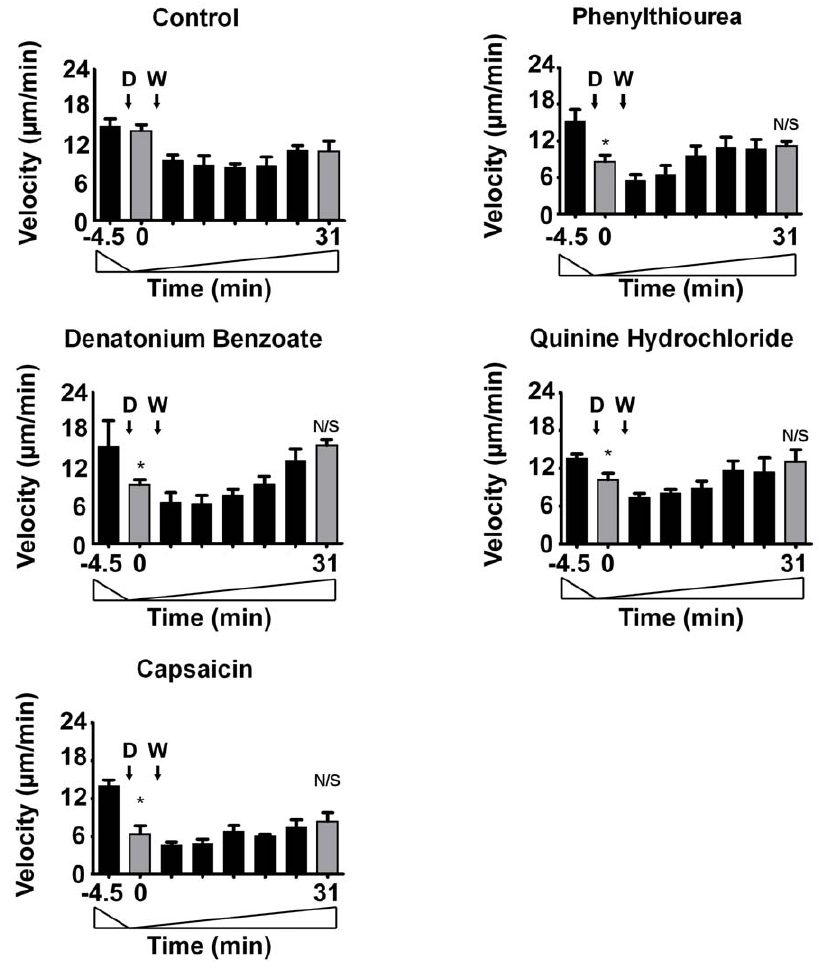
Figure 7. Analysis of Dictyostelium cell behaviour recovery post-tastant exposure. Mean data representing cell velocity during random cell movement over a 35 min period, with average cell velocity measured for 4.5 min under control conditions (at 2 4.5–0 min), prior to the addition of tastants at 0 min (D), followed by removal of tastants at 4.5 min (W), and the recording of recovery up to 31 min. Tastant concentrations used are: 1 mM denatonium benzoate, 3 mM phenylthiourea, 350 m M quinine hydrocholide, and 50 m M capsaicin. Data is presented as a mean 6 S.E.M for each 4.5 min period, with triplicate experiments analysing approximately 30 cells in each. Grey bars indicate the equivalent time periods used in the analysis of cell velocity comparing control and each condition. N/S = non significant, * = P , 0.05.